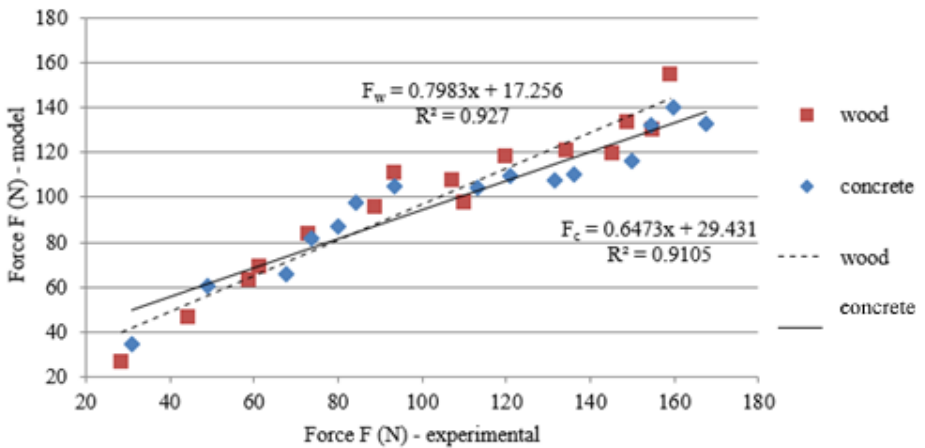
Figure 5. Comparison of the force values obtained based on experimental tests and on the numerical model for both substrates. Fw —means force for wood surface, Fc —means force for concrete surface.